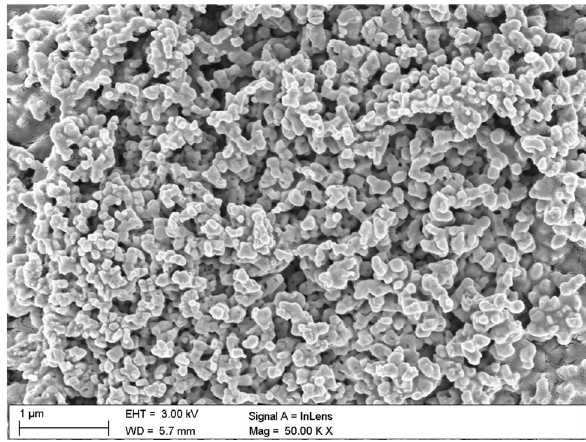
Figure 8. The Nb 2 O 5 nanoparticles clusters in PMMA film.